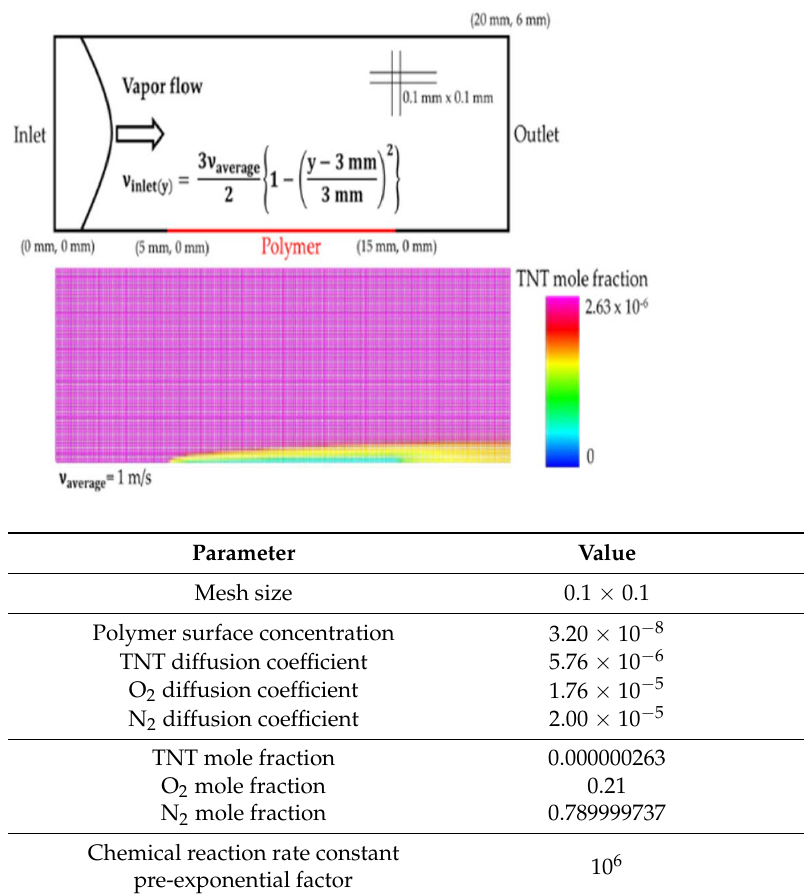
Figure 6. ( a ) The peak values of the first derivatives of the reciprocal normalized integrated intensities obtained from Figure 5c,d as a function of flow rate. The first derivative represents how rapidly the non-radiative recombination rate increases as TNT molecules are attached on the surface or diffused into the film. The effect of flow rate on the first derivative is clearly observed. ( b ) Effect of flow velocity on surface reaction rate. The black points are those obtained from CFD simulation. A fitting curve is shown in red. The fitting formula is included. Table 1. Simulation parameters. A simulation result of the TNT mole fraction is